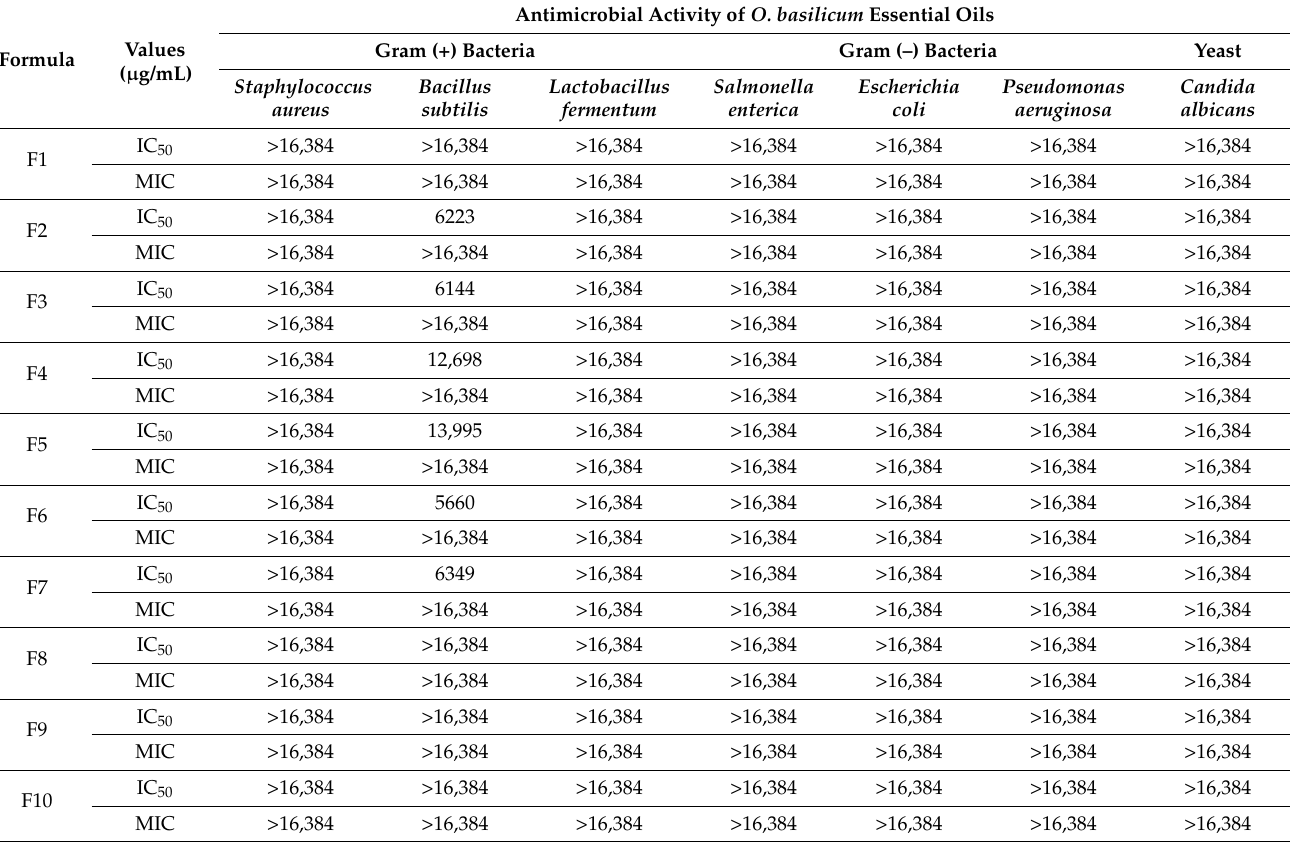
Table 4. Antimicrobial activity of essential oils of O. basilicum cultivated under different light